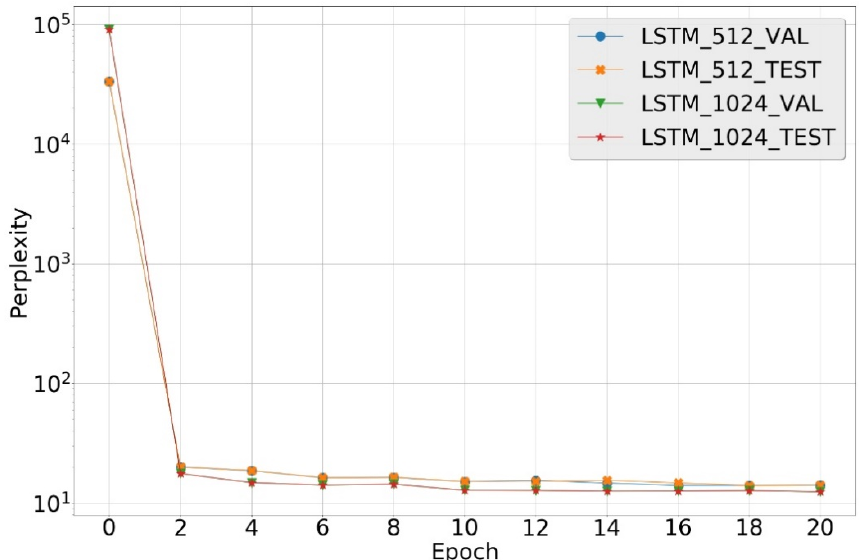
Figure 11. Perplexity of Cases 1 and 2.